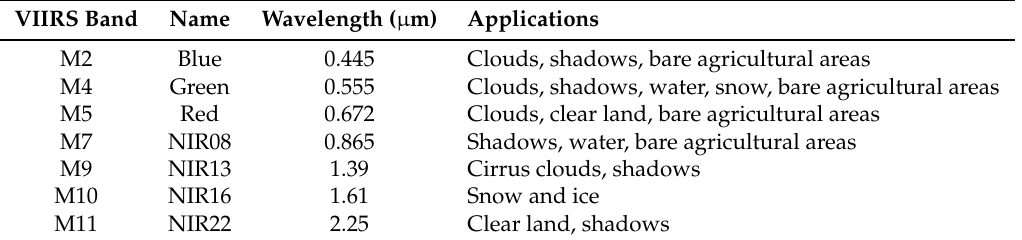
Table 2. VIIRS bands and their role in cloud and shadow detection and removal/separation of false cloud and shadow